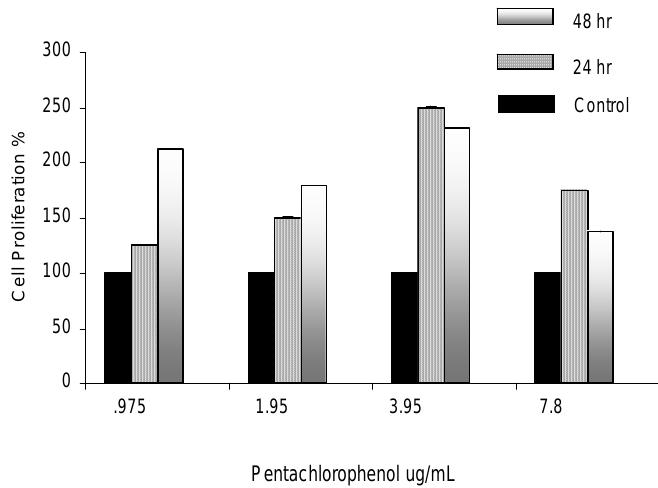
Figure 2. Mitogenic effect of pentachlorophenol on AML 12 mouse hepatocytes cells. AML 12 mouse hepatocytes were treated with sublethal concentrations of PCP (.975 – 7.80 µ g/mL) for a 24 h and 48 h period. Cell proliferation was determined based on the MTT assay.